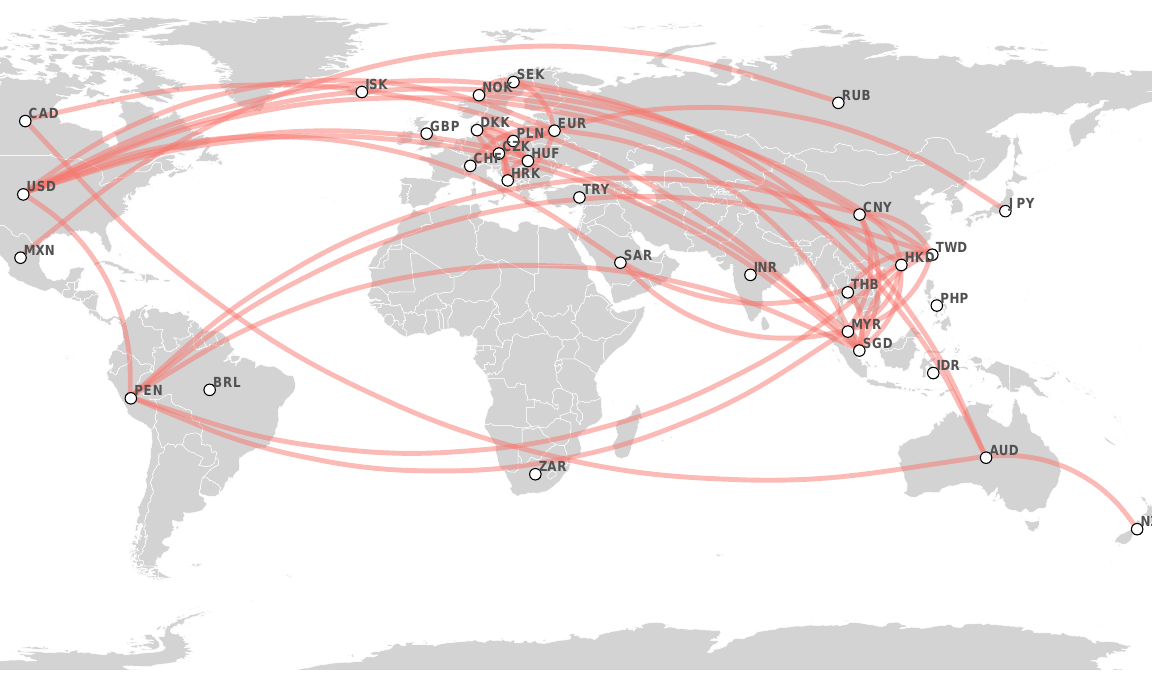
Figure 6. Estimated currency network based on 2018 foreign exchange markets data. gray